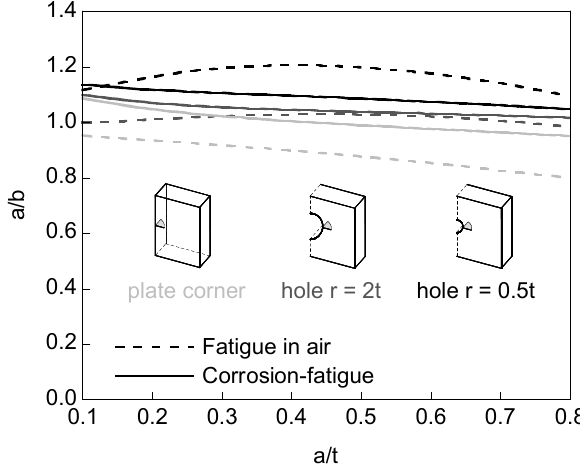
Figure 9. Preferential propagation paths.